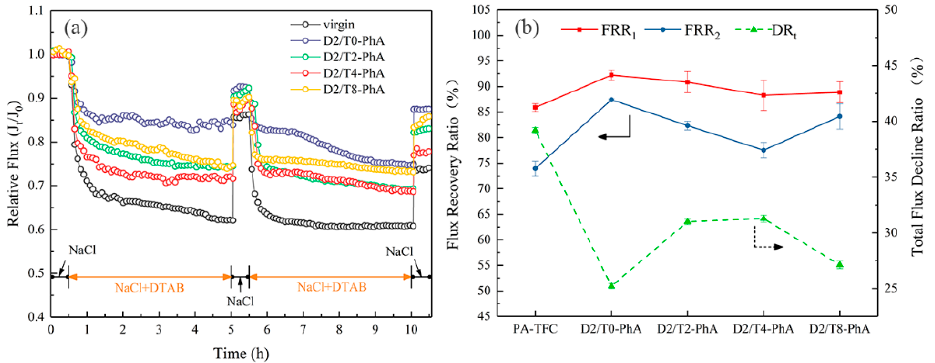
Figure 6. ( a ) Time-dependent relative water flux and ( b ) FRR i values and DR t values of PA-TFC and DA/TA-PhA membranes tested with 2000 mg·L − 1 NaCl and 100 mg·L − 1 SA aqueous solution.